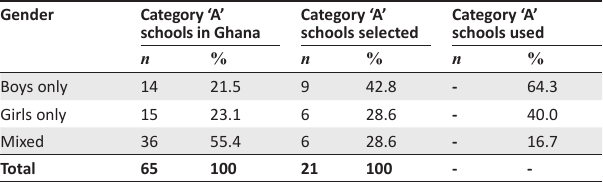
TABLE 3: Distribution of schools by gender.